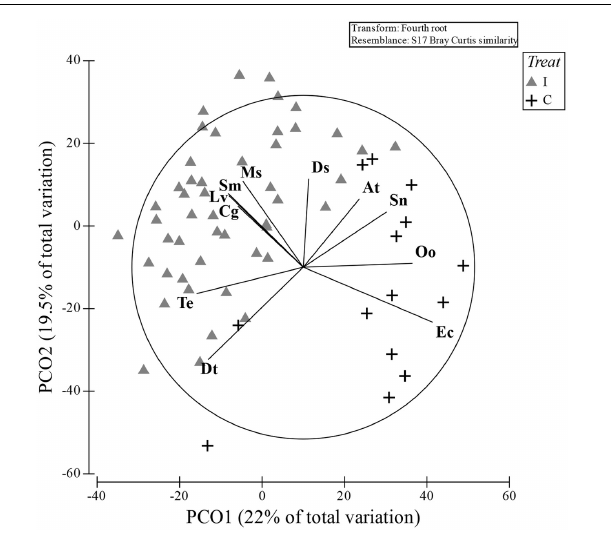
FIGURE 3 | PCO ordination plot obtained by the Bray–Curtis similarity matrix of the communities present in both treatment: impact (I) and control (C). The species that most correlated with two main axis are superimposed (Pearson’s correlation index; cut-off 0.5). Dt, Donax trunculus ; Te, Tellina exigua ; Cg, Chamelea gallina ; Sm, Solen marginatus ; Lv, Liocarcinus vernalis ; Ms, Mactra stultorum ; Ds, Donax semistriatus ; At, Achantocardia tuberculata ; Sn, Sipunculus nudus ; Oo, Ophiura ophiura ; Ec, Echinocardium cordatum